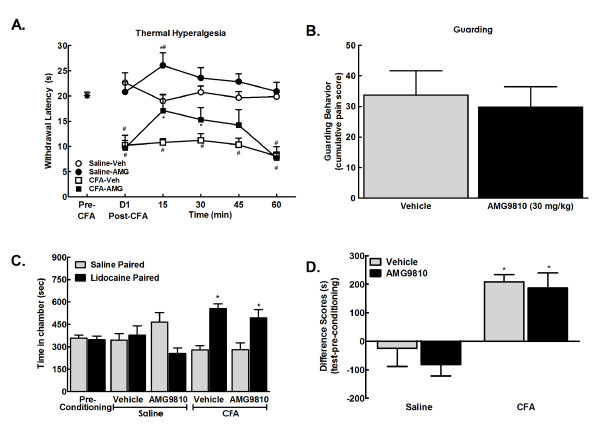
A. CFA reduced withdrawal latency within 24 hrs post-CFA. AMG9810 (30 mg/kg, i.p.) reversed CFA-induced thermal hyperalgesia within 15 min, with paw-flick latencies returning to pre-drug levels 60 min post administration. AMG9810 also elevated paw-flick latencies of control (saline treated) rats with 15 min of administration. *p < 0.05 vs. post-CFA, #p < 0.05 vs. pre-CFA, n = 5-6. B. Systemic administration of the selective TRPV1 receptor antagonist, AMG9810 (30 mg/kg i.p.) failed to alter CFA-induced guarding behavior 24 hours following injury, p > 0.05 vs. vehicle. C. Pre-conditioning values did not differ between treatment groups, therefore values were pooled for graphical representation. Lidocaine increased time spent in the lidocaine paired chambers in both the AMG9810 and vehicle treated rats, *p < 0.05 vs. pre-conditioning, n = 5. D. Difference scores calculated as test time - preconditioning time spent in the lidocaine chamber confirm that CFA treated rats increased time spent in the lidocaine paired chambers in both the vehicle and AMG9810 treatment groups, *p < 0.05 vs. saline/vehicle.